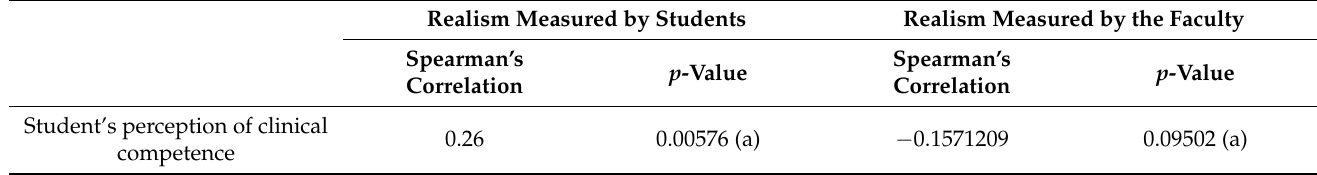
Student’s perception of clinical